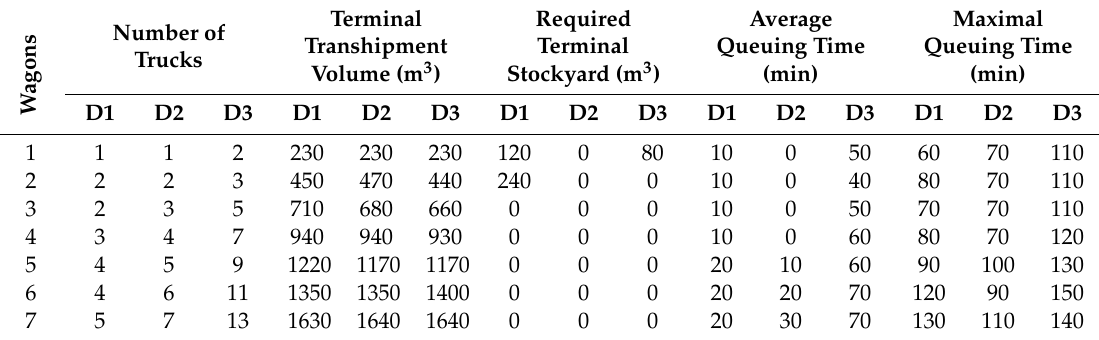
Table 5. Best performing simulation results for strategy NO STOCKYARD (no or low required terminal stockyard) for one train pick-up.